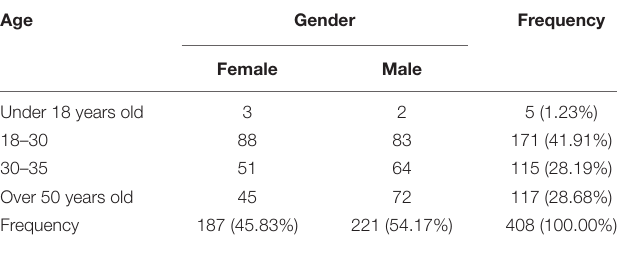
TABLE 1 | Demographic distribution characteristics of the